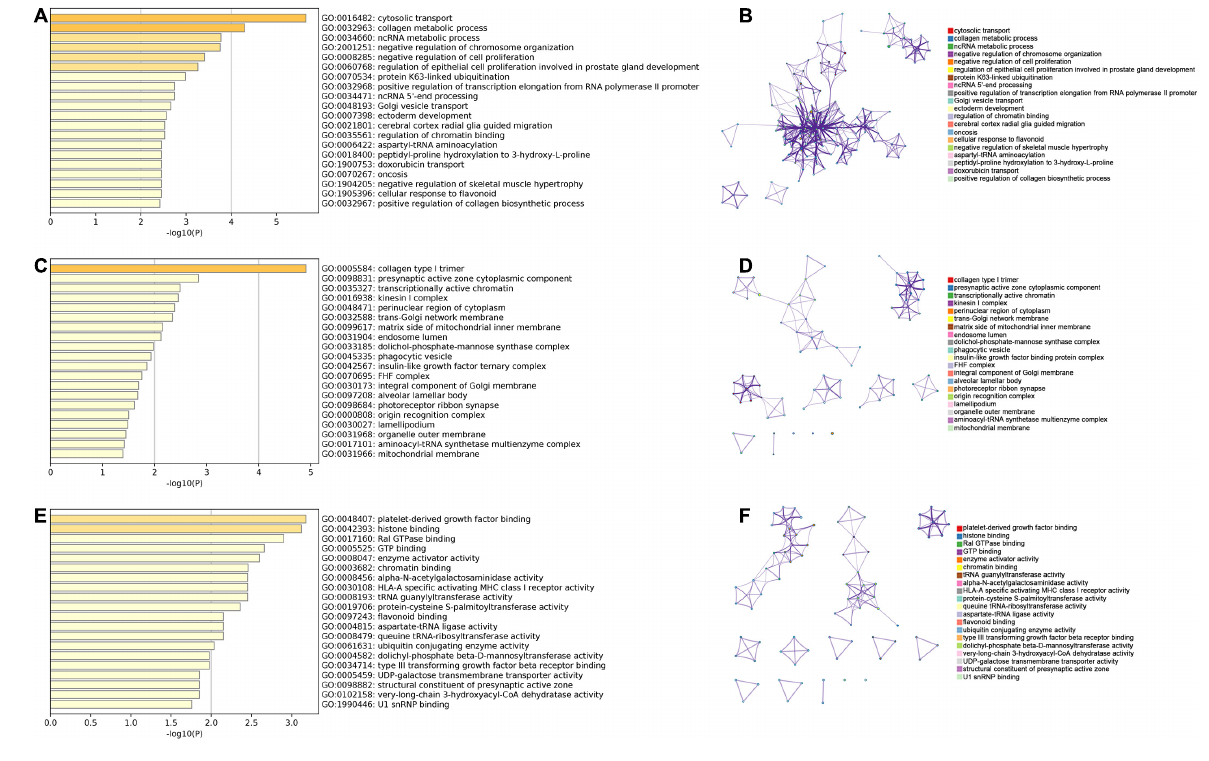
Frontiers in Cell and Developmental Biology |